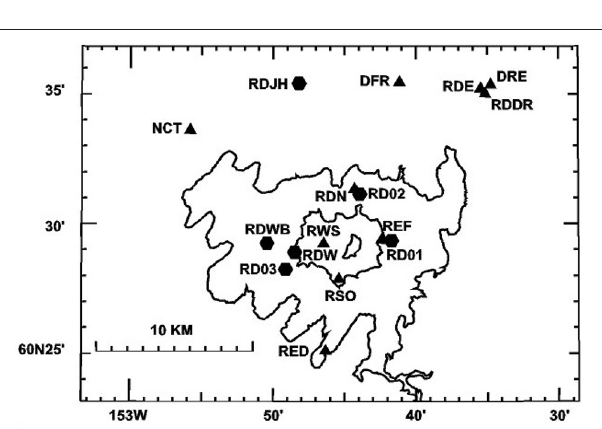
FIGURE 2 | Map showing locations of seismic stations that operated surrounding Redoubt Volcano, Alaska between 1989 and 2010 from Power et al. (2013). Triangles correspond to short-period vertical seismometers while hexagons reflect 3-componet broadband instruments. Contours reflect 3,000, 6,000, and 9,000 foot